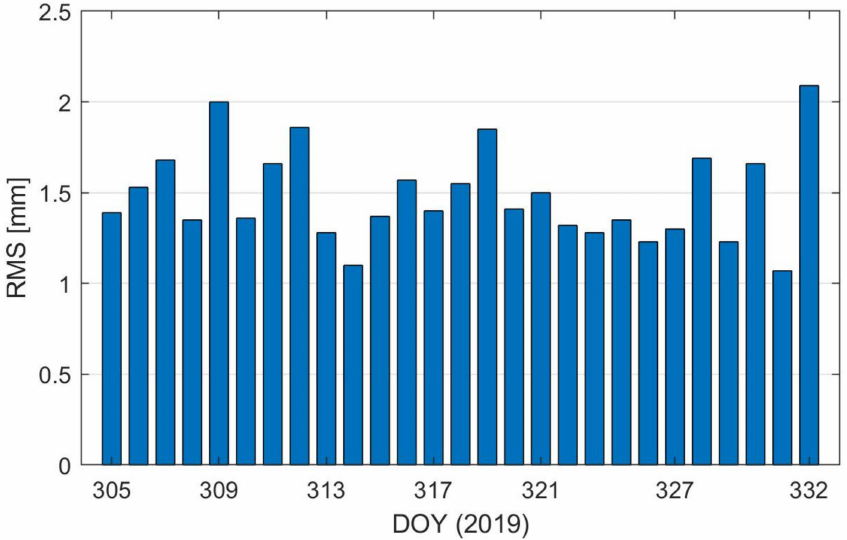
Figure 4. Difference in 3D between the National University of Defense Technology (NDT) and Xi’an Research Institute of Surveying and Mapping (CHS) solutions (excluding maneuver